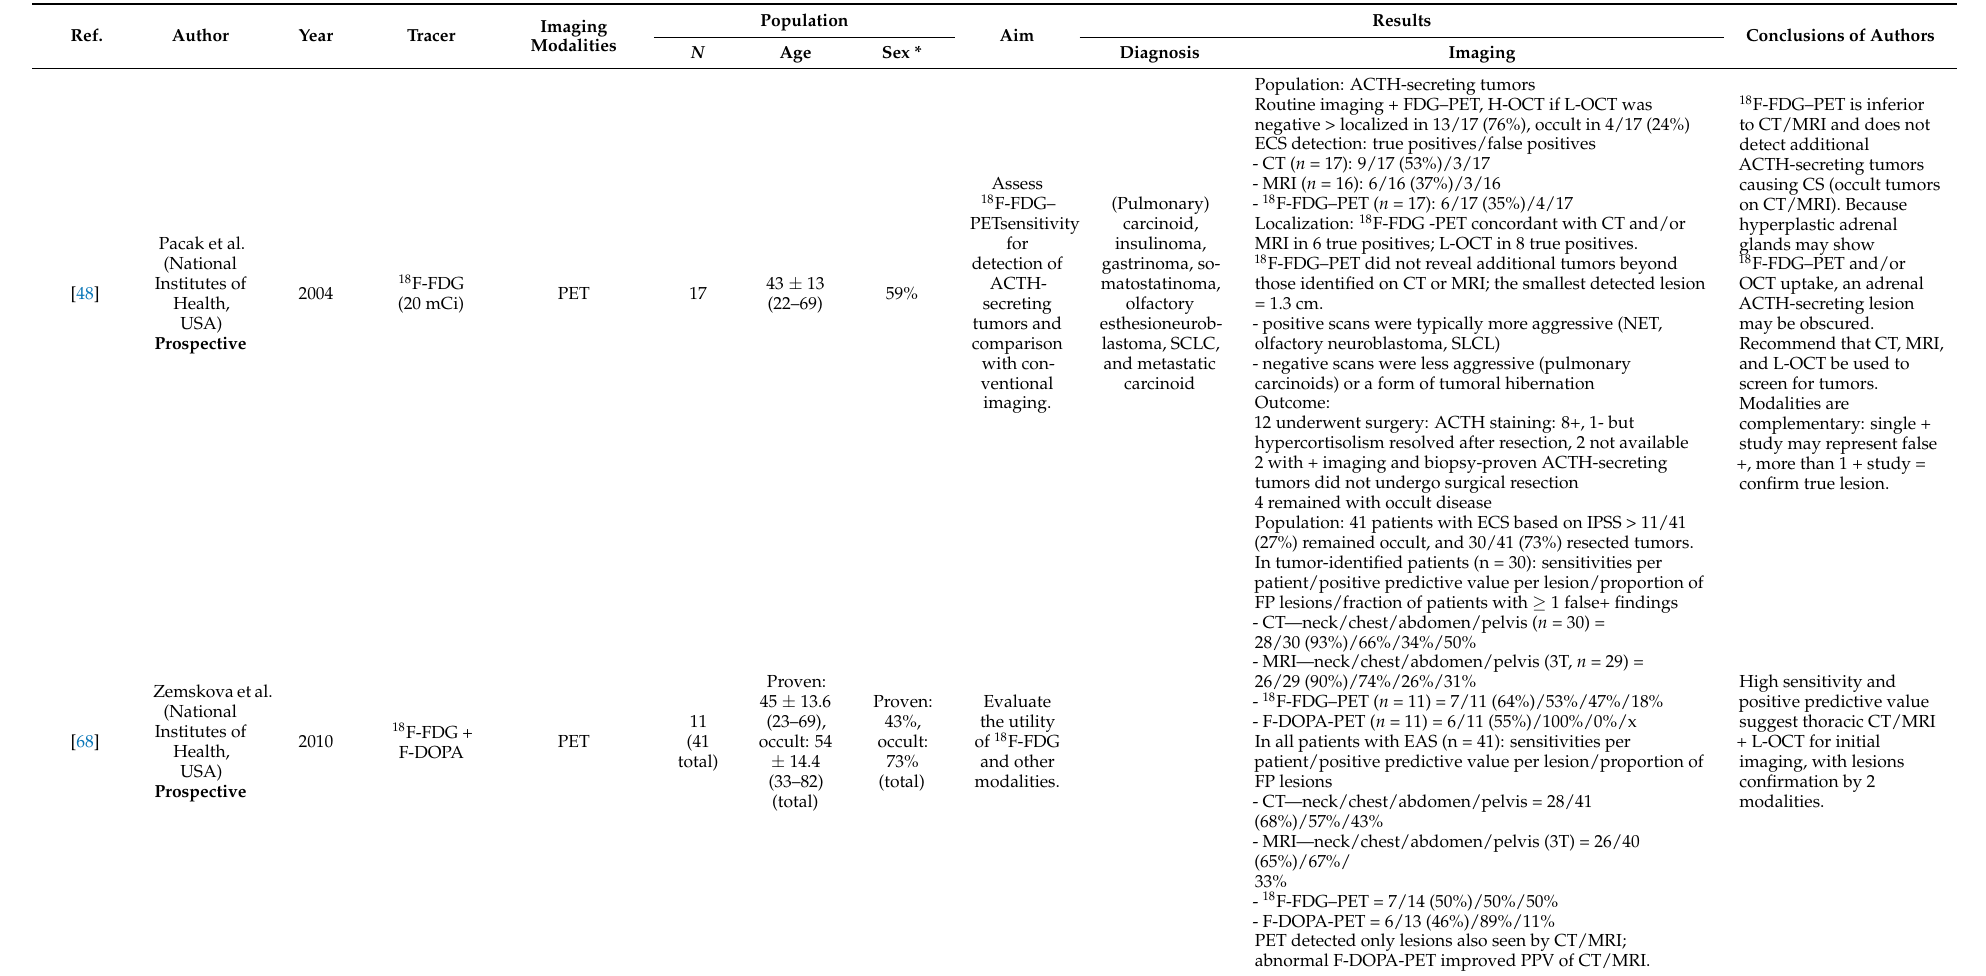
Table A1. Original studies on functional imaging in ectopic Cushing’s